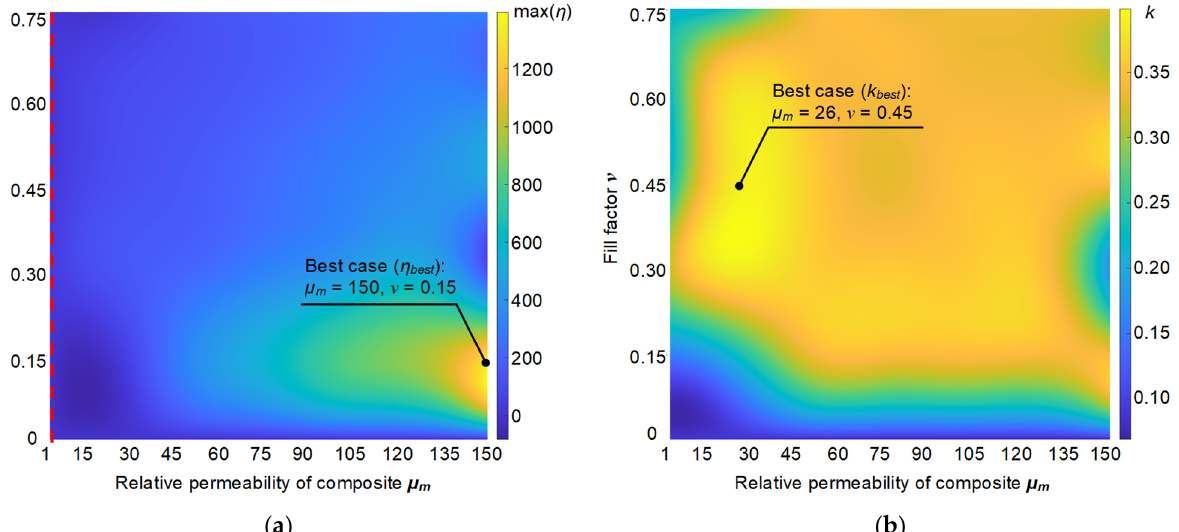
Figure 4. The results of maximizing objective function η = f( C ) for different fill factors ν and permeabilities µ m at f r = 25 kHz: ( a ) energy transfer gain η and ( b ) magnetic field ratio k .